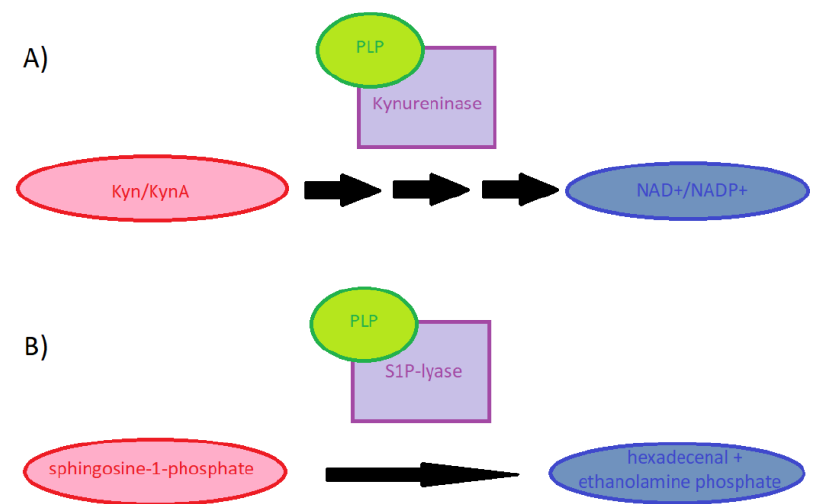
Abbreviations: Kyn: kynurenine, KynA: kynurenic acid, NAD + : nicotinamide adenine dinucleotide, NADP + : nicotinamide adenine dinucleotide